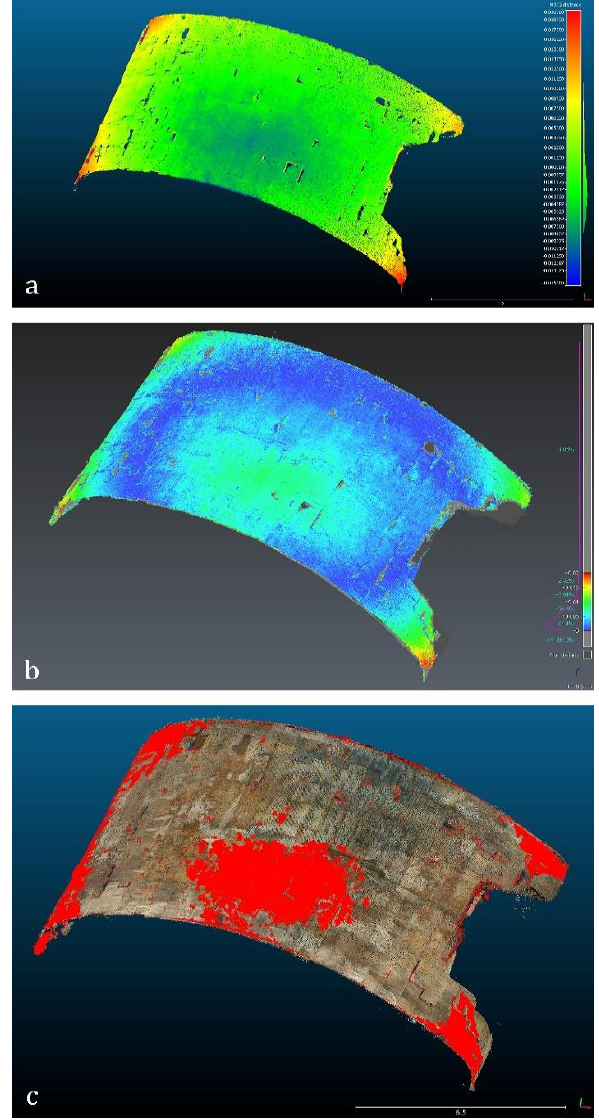
Figure 8. Comparison between TLS and GoPro point clouds: a) 3D model with M3C2 distances b) 3D model of distances computed with 3DReshaper c) 3D model with, in red, the area in which the change is significant, considering the registration error of the TLS point cloud on the georeferenced targets (paragraph 3).